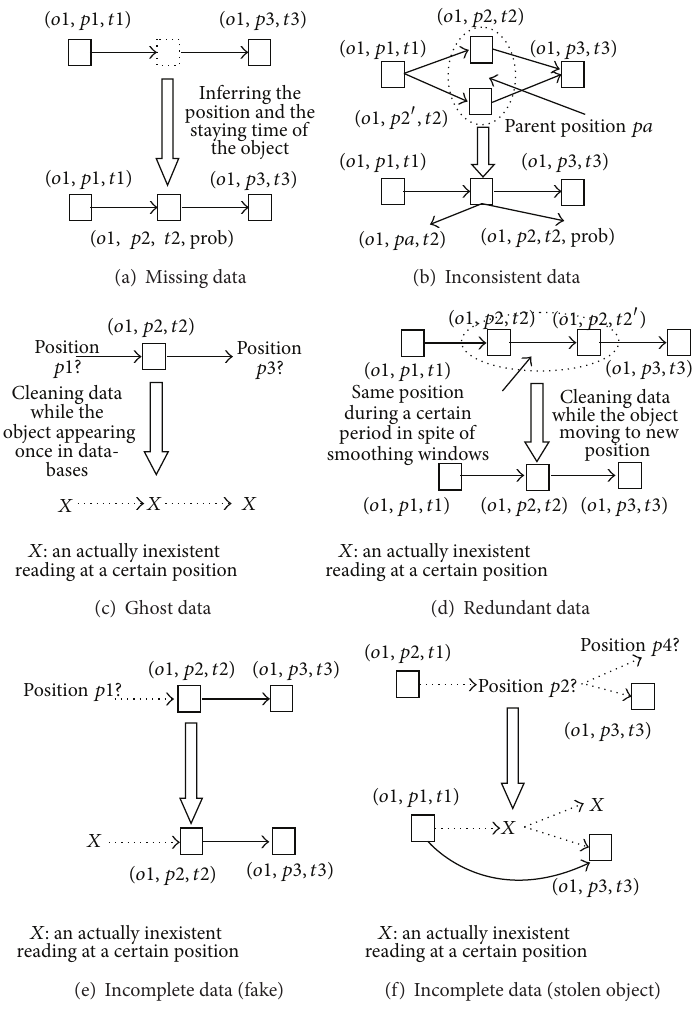
Figure 4: Inferring uncertain and incomplete